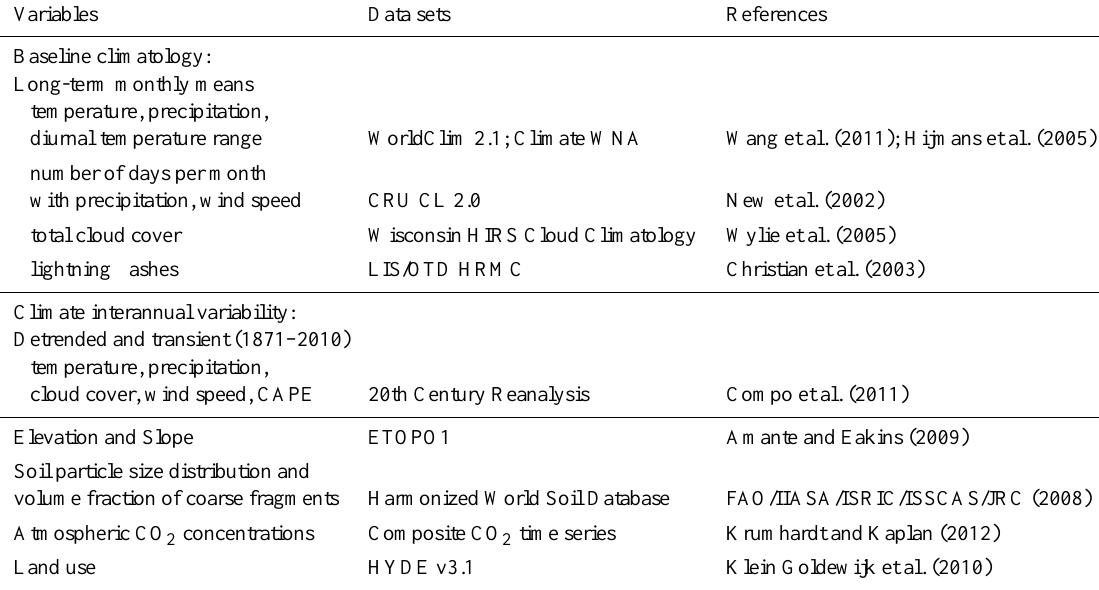
Table 3. Data sets used to drive